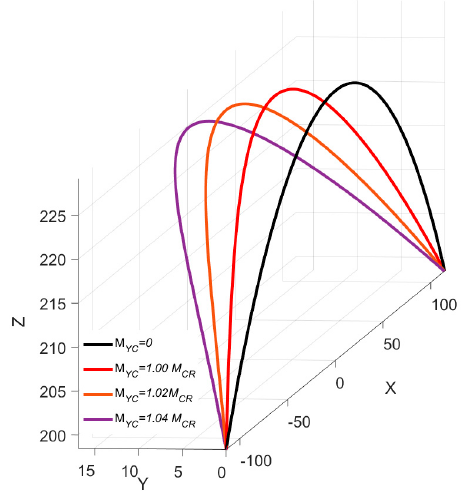
Figure 20. Spatial configurations of the curve beam subject to negative moment in lateral buckling analysis.